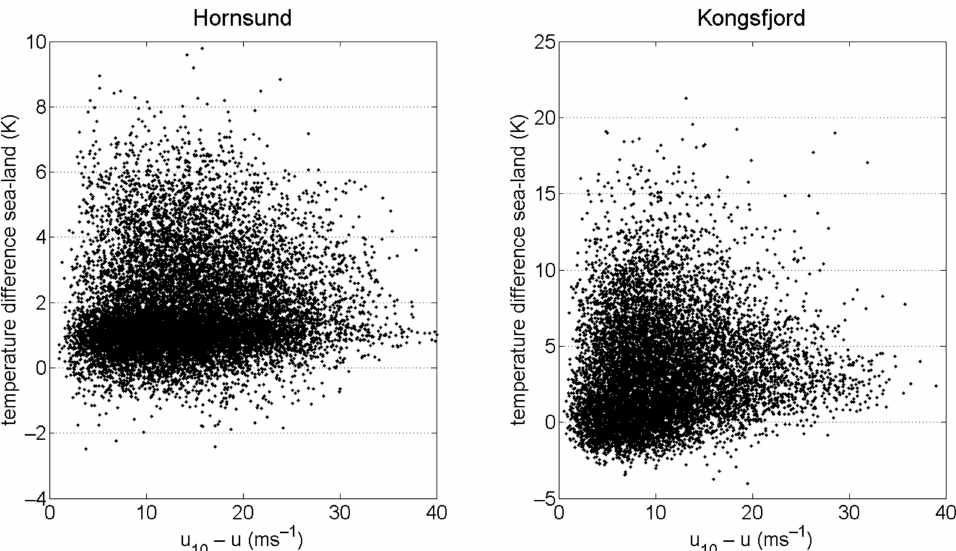
Figure 9. Graphs representing dependence of the air temperature difference at the station and over the open sea and the difference of large-scale and local wind velocity in Hornsund (left panel) and Kongsfjorden (right panel) when the mesoscale land-sea breeze type circulation was observed between 1994 and